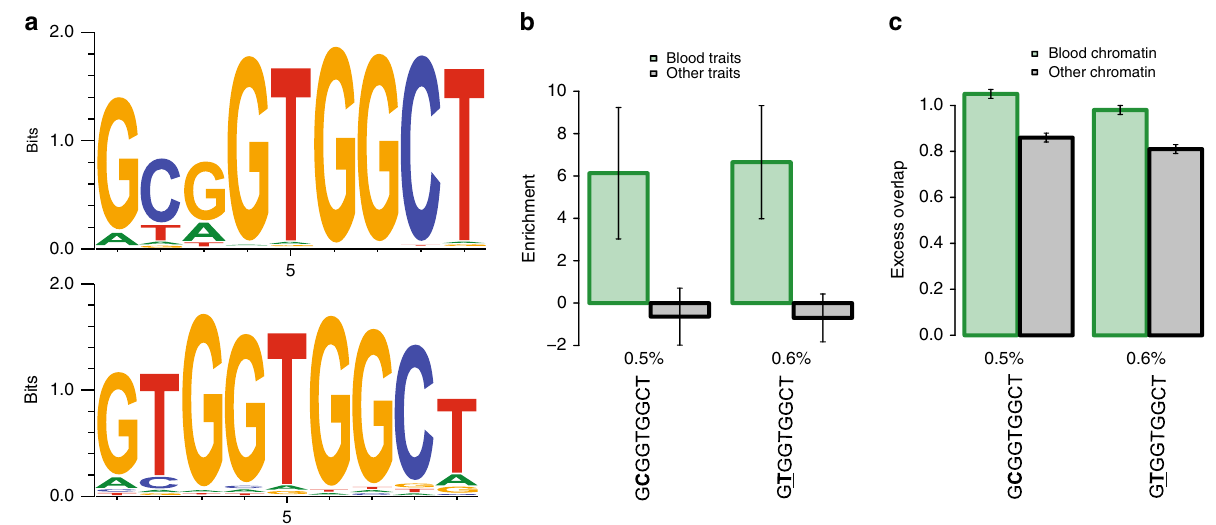
Fig. 3 Higher enrichment of GCGGTGGCT and GTGGTGGCT for blood traits. For each of these 9-mers, we report a sequence logo (top panel for GCGGTGGCT and bottom panel for GTGGTGGCT); b heritability enrichment for blood traits and other traits; and c excess overlap with chromatin annotations in blood and chromatin annotations in other tissues. Results are meta-analyzed across 41 independent blood and other traits. Numerical values of %SNPs are provided for each annotation. Error bars denote 95% con fi dence intervals Numerical results are reported in Supplementary Table 13b, c